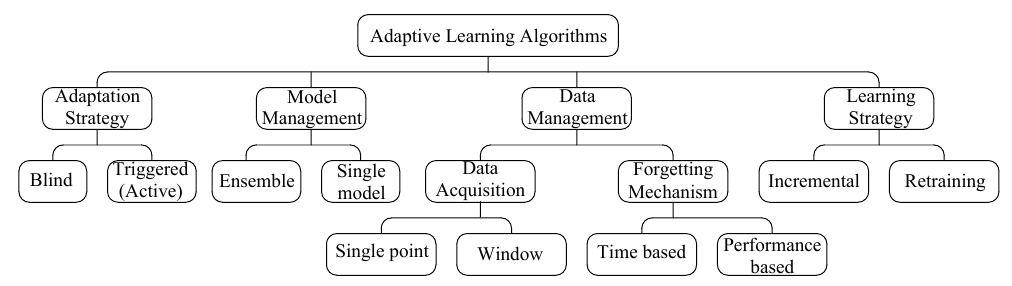
Figure 2. Taxonomy of adaptive